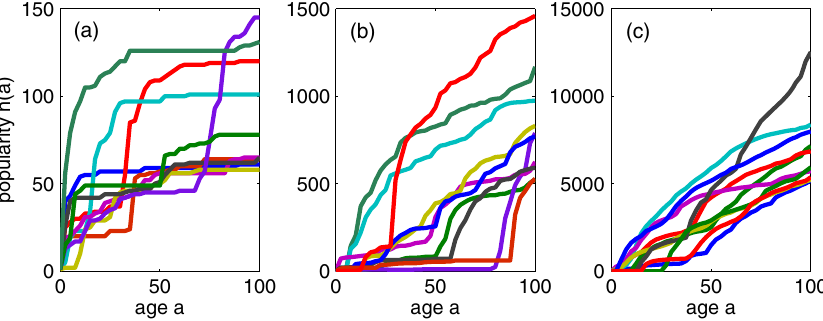
FIG. 2. Examples of the age dependence of meme popularity from numerical simulations of the model. Each panel shows the popularity of 10 different memes; the memes plotted are chosen at random from those whose popularity at age 100 is of order (a) 10 2 , (b) 10 3 , or (c) 10 4 . For model parameters, see the caption of Fig.